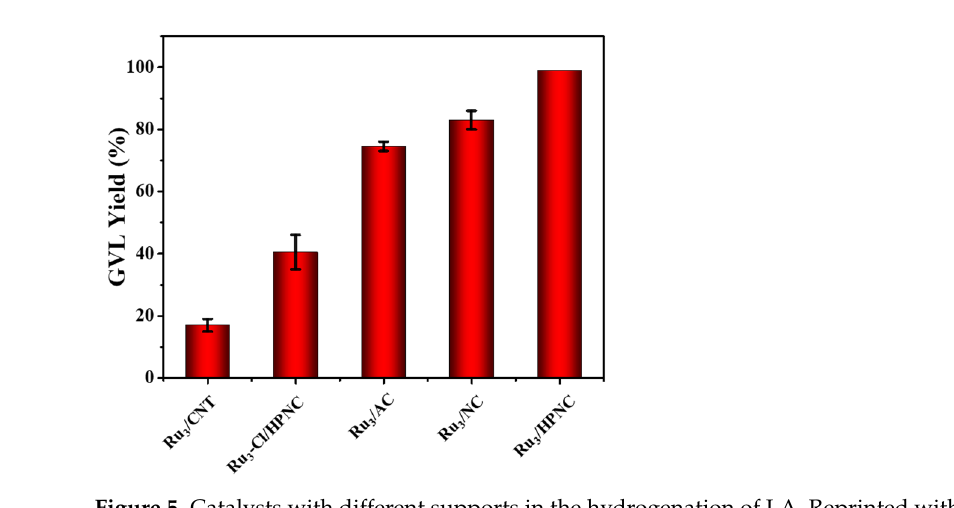
Figure 4. The preparation procedure of Ru/HPNC catalysts. Reprinted with permission from Ref.